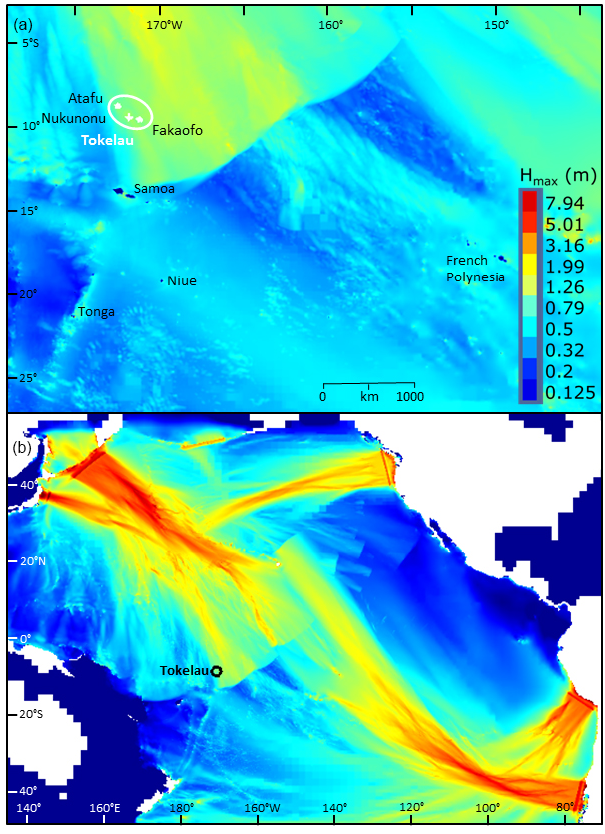
Figure 6. Summary of maximum wave amplitudes for all distant sources excluding Kuril. The regional view (a) , with the Tokelau Islands outlined in white, upper left. And a wider view of the Pa- cific Ocean (b) , with the location of Tokelau indicated by the black circle. Note that simulations stop after the majority of the tsunami- wave train has passed Tokelau, giving a truncated appearance to farthest extents of the wave fields. The height is plotted on a loga- rithmic scale (same for both images) to adequately capture the wide range of wave amplitudes in both frames (0.125m in dark blue to over 7.9m in